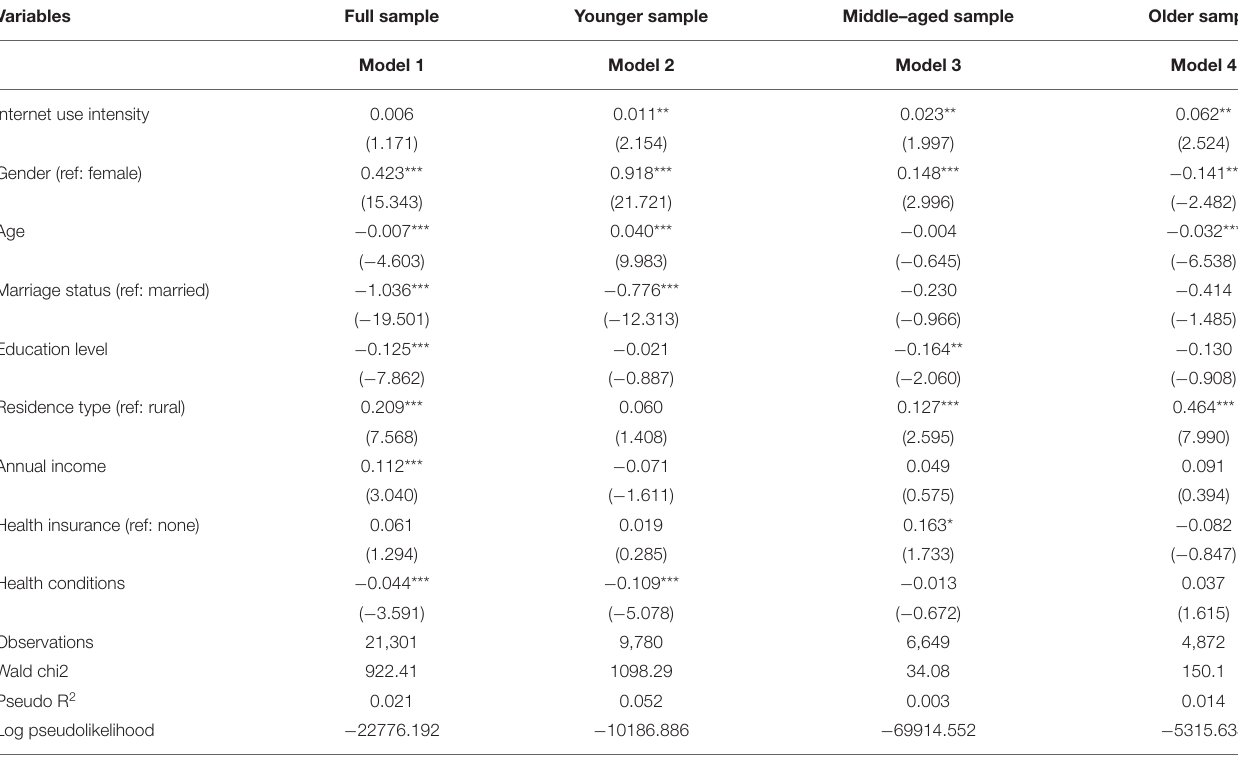
TABLE 3 | Results of the relationship between internet use intensity and body weight ( N =